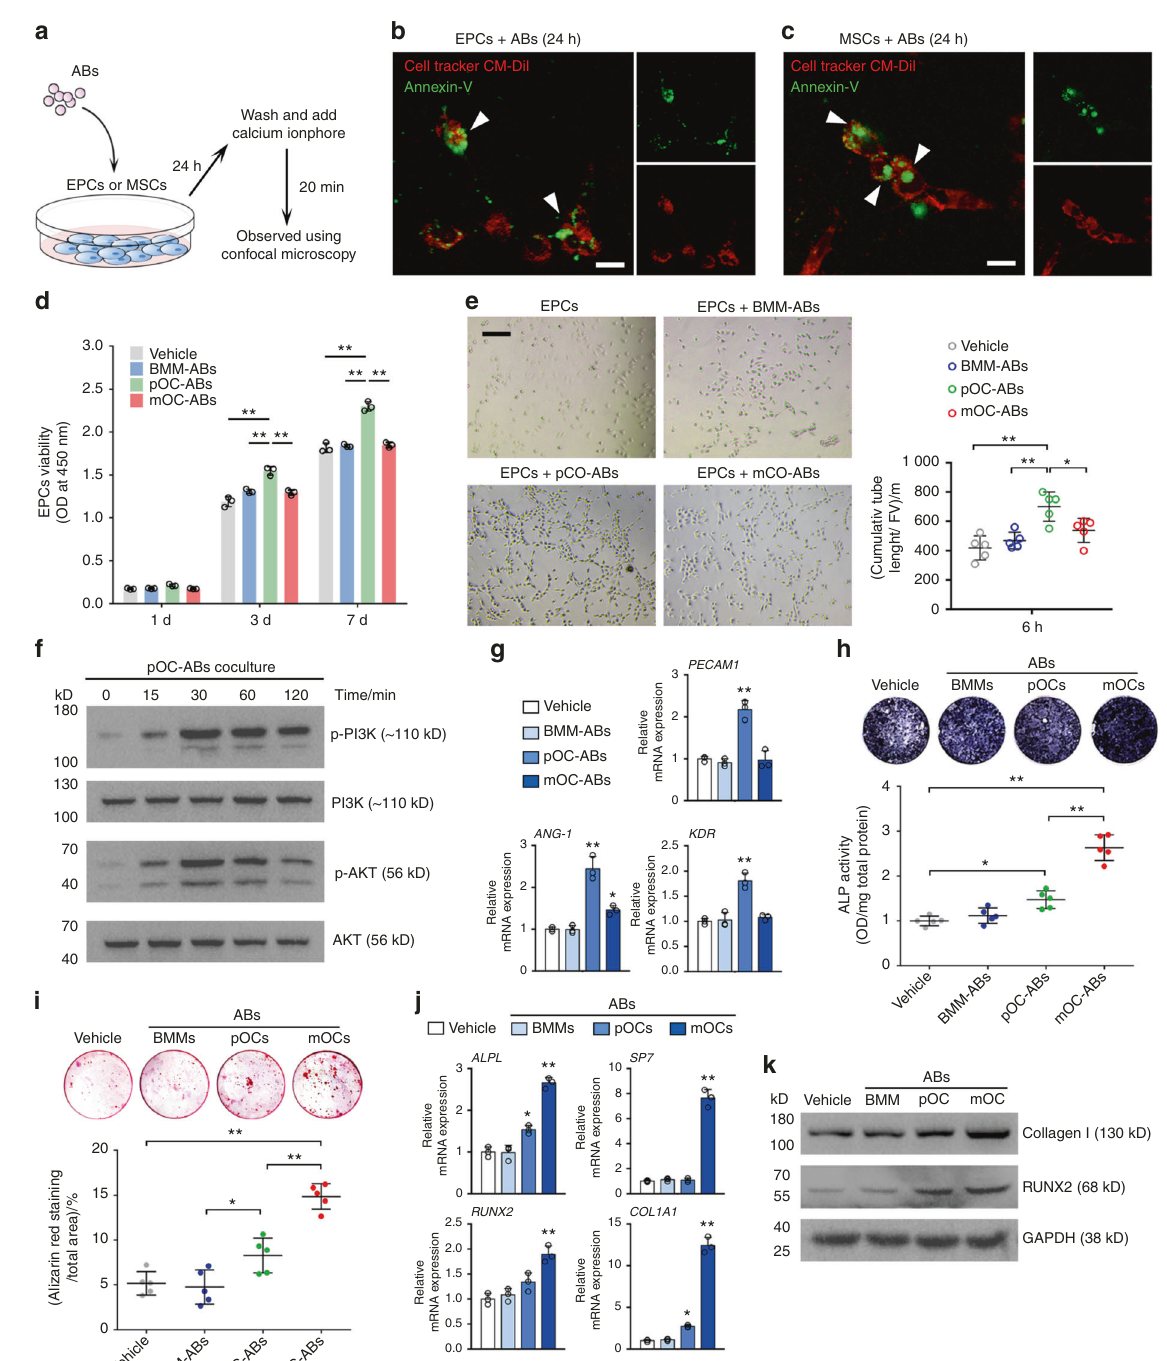
Fig. 4 pOC-ABs and mOC-ABs inherit distinct biological functions from their parental cells. a Schematic diagram of the AB engulfment assay. Representative confocal micrographs showing cell tracker CM-DiI-labeled ( b ) EPCs or ( c ) MSCs (red) incubated with Annexin-V/FITC-labeled ABs (green). The merged images are shown in the left panel. The white arrows indicate ABs engulfed by recipient cells. The bar represents 10 μ m. d EPC viability was assessed at 1, 3, and 7 days after treatment with different ABs. “ Vehicle ” represents EPCs cultured with complete medium. e Tube formation assay of EPCs cultured with ABs for 6 h. Representative images (left panel) and quanti fi cation analysis of the calculated tube lengths (right panel) are shown. The bar represents 100 μ m, n = 5. f The levels of phosphorylated PI3K and AKT in EPCs were determined by western blot analysis. g RT-qPCR analysis of Pecam1 , ANG-1 , and Kdr expression in EPCs treated with medium containing different ABs. h Representative images of ALP staining and quanti fi cation of ALP activity. “ Vehicle ” indicates MSCs cultured with complete medium, n = 5. i Representative images of ARS staining and quantitative analysis of calcium deposits in MSCs. “ Vehicle ” indicates MSCs cultured with complete medium, n = 5. j RT-qPCR analysis of Alpl , Osx , Runx2 , and Col1a1 expression in MSCs cultured with medium containing different ABs. k Western blots of the osteogenic markers Collagen I and RUNX2 in MSCs cultured with ABs. The data in the fi gures are presented as the average ± SD values. Statistically signi fi cant differences between the treatment and control groups are indicated as * ( P < 0.05) or ** ( P <